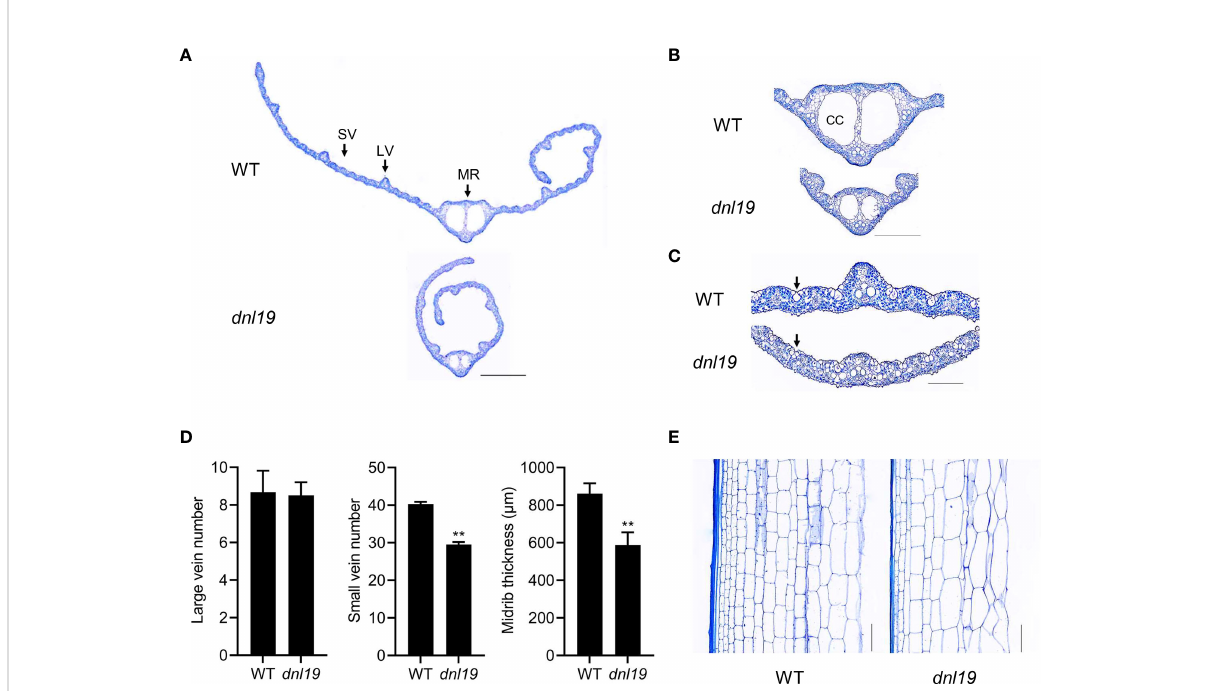
FIGURE 2 Effects of the dnl19 mutation on leaf and culm structure. (A) Cross section of fl ag leaf blades in WT and dnl19 plants. SV: small vein, LV: large vein, MR: midrib. Bar = 1 mm. (B, C) Magni fi ed images of the leaf vein shown in (A) . CC: clear cell, Arrow: bulliform cell. Bar = 0.5 mm in (B) and 0.2 mm in (C) . (D) Number of large and small veins, and midrib thickness in leaf blades of WT and dnl19 plants. Data are means ± SD ( n =10, ** P < 0.01, Student ’ s t -test). (E) Longitudinal section of the 2nd internodes at the mature stage from WT and dnl19 . Bar = 0.1